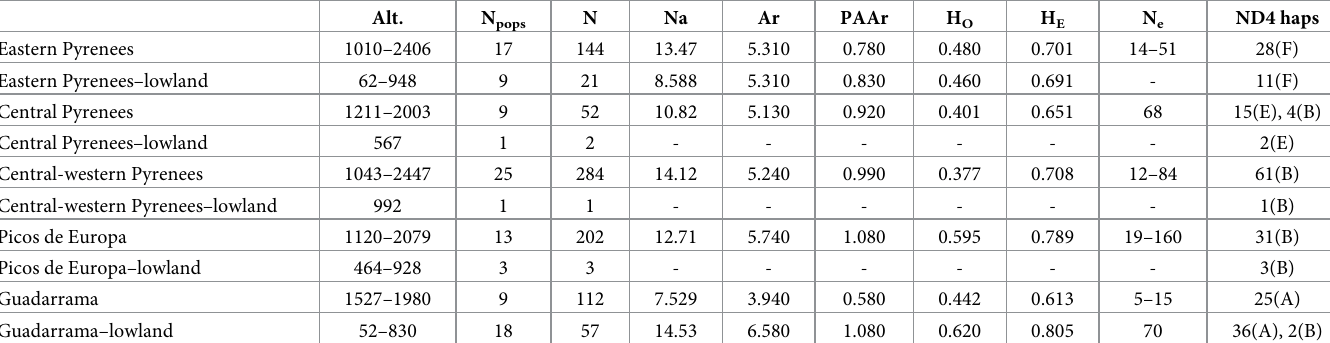
Table 1. Genetic diversity parameters as estimated from microsatellites for each analysed mountain region and corresponding lowland areas. Alt. N